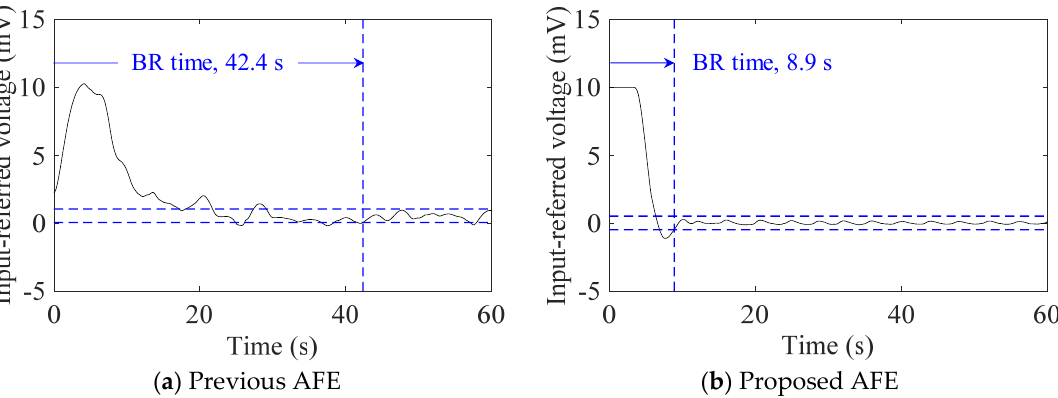
Figure 7. Examples of transient response of cECG baseline to the onset of supine position of subject #A. Original cECG signals were measured using the ( a ) previous AFE and ( b ) proposed AFE, and then filtered to extract their baselines, respectively. The baseline recovery (BR) time is also indicated in each response.